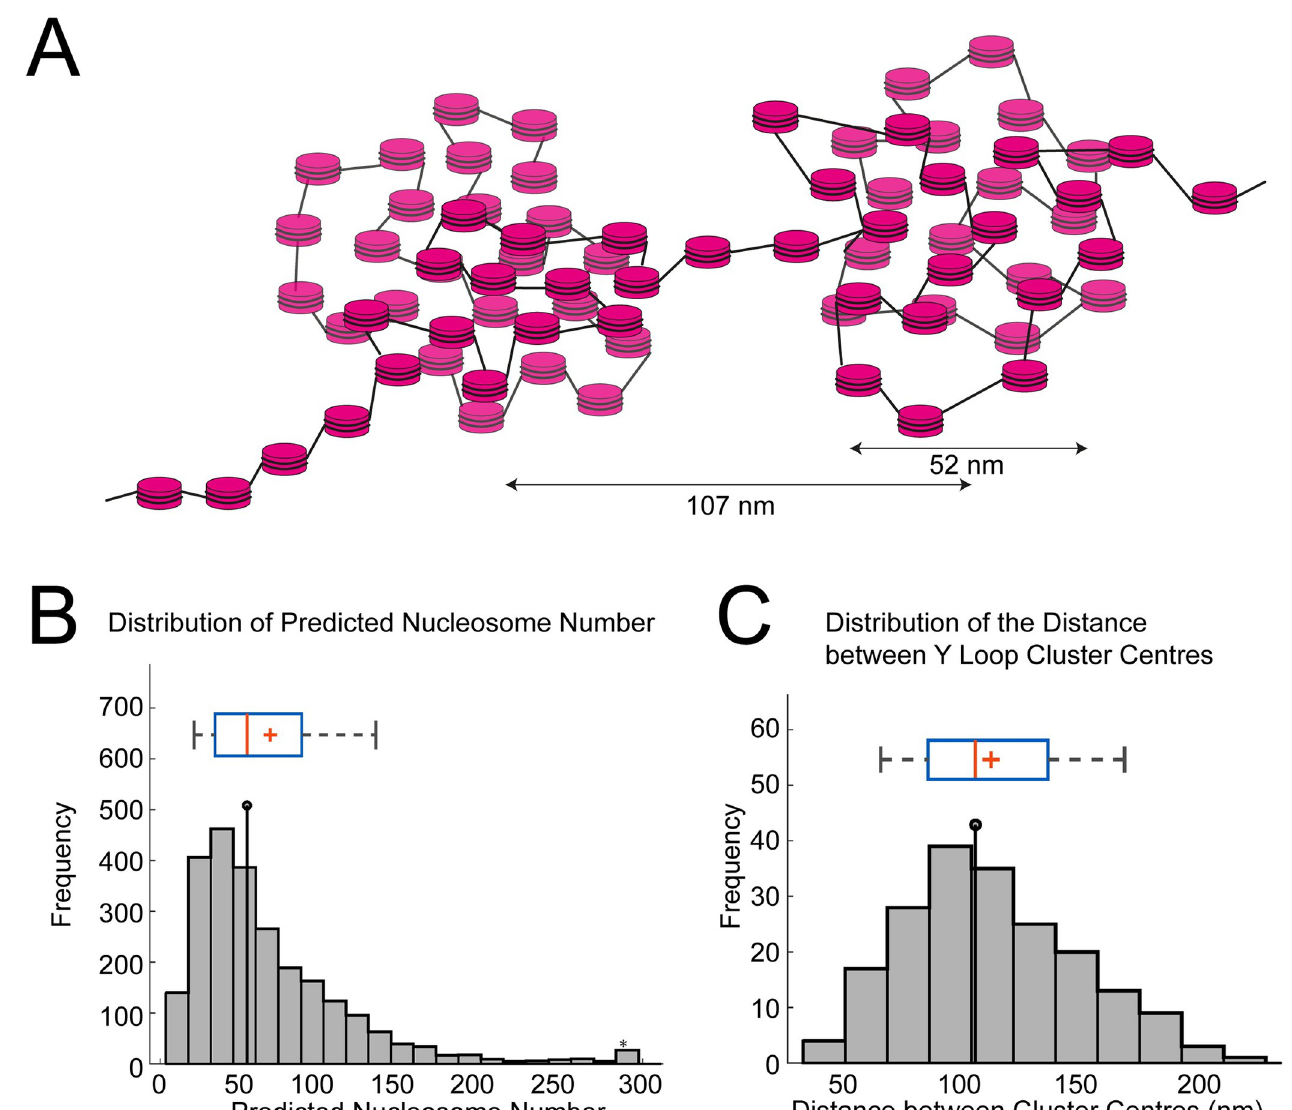
Fig 4. Estimating the number of nucleosomes in the Y loop clusters. (A) Schematic of nucleosome clusters along the Y loops with nucleosomes depicted as magenta discs. The median FWHM of the clusters measured was 52nm, shown here against a cluster as an example, as well as the median distance between cluster centres (107nm). (B) Histogram showing the number of predicted nucleosomes within the measured clusters along the Y loops. The FWHM was used to estimate the maximum volume of the clusters and find the theoretical maximum of nucleosomes that would fit within that volume. 35% of this maximum was used as an estimate of nucleosome number based on how condensed the nucleosomes might be within these clusters. The median is 54. (C) Histogram of inter-cluster distance, the median is 107nm. The box and whisker plots are as in Fig 3.